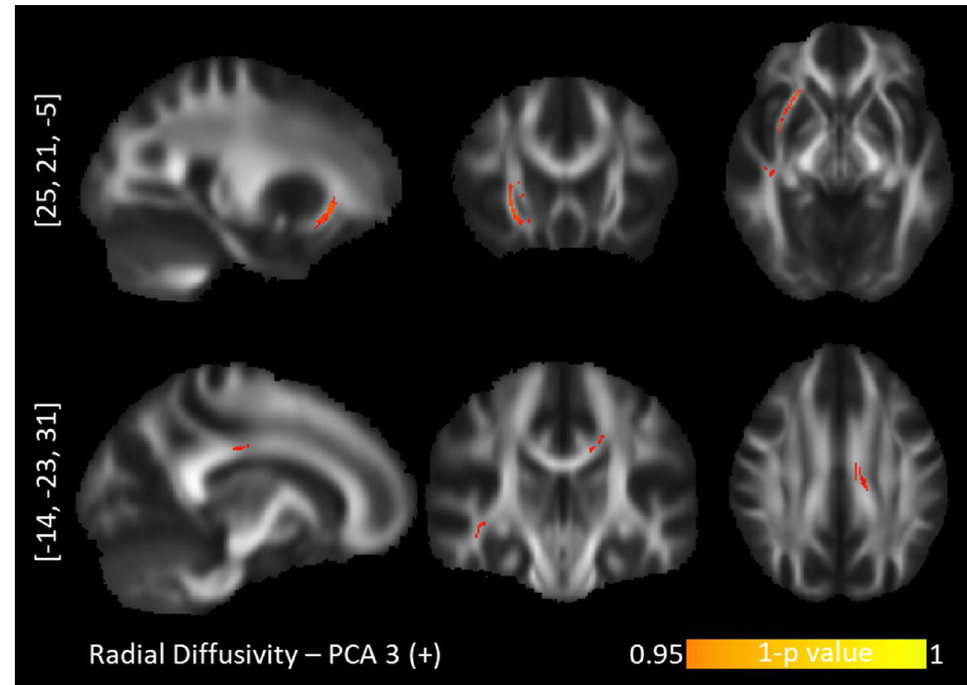
Figure 4. TBSS positive correlations between radial diffusivity and the "Short-term approach behavior". Top row: inferior fronto-occipital fasciculus. Bottom row: posterior corpus callosum.